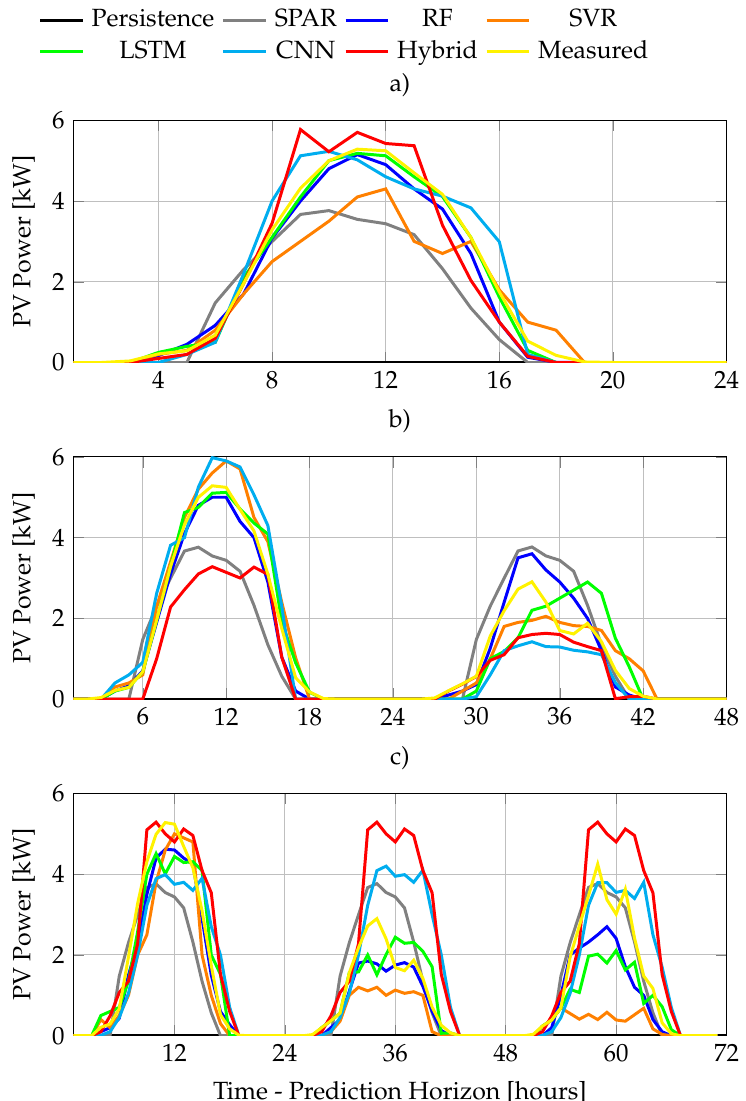
Figure 12. Sample forecast comparison: ( a ) one, ( b ) two, and ( c ) three days ahead,